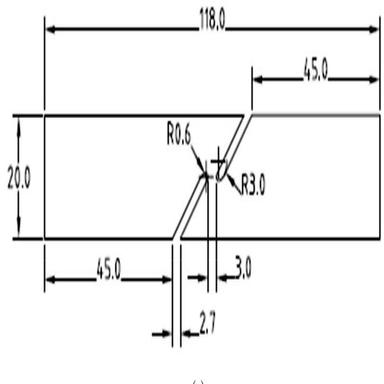
Ductile fracture test specimens in shear dominant zone and forming limit diagram (FLD) zone: (a) pure shear, (b) uniaxial tension, and (c) plane strain tension.